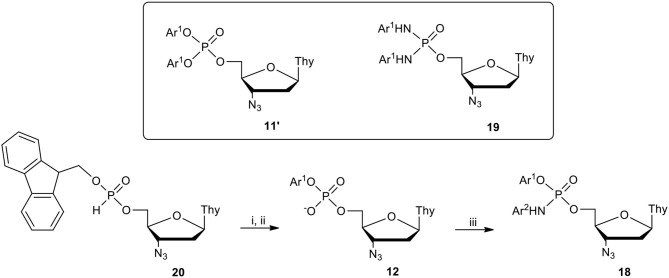
Scheme of the synthesis of aryl nucleoside (N-aryl)phosphoramidates via aryl nucleoside phosphodeisters on the example of AZT derivatives. (i) I2, Ar1OH, 1.5 molar equiv. both; (ii) CH3CN/Et3N 2: 1 (v/v), 10 mL/1 mmol, 20 min.; (iii) Ar2NH2 1.5 molar equiv., TPSCl 3 molar equiv. in CH2Cl2/MeIm 9: 1 (v/v), 10 mL/1 mmol, 60 min.